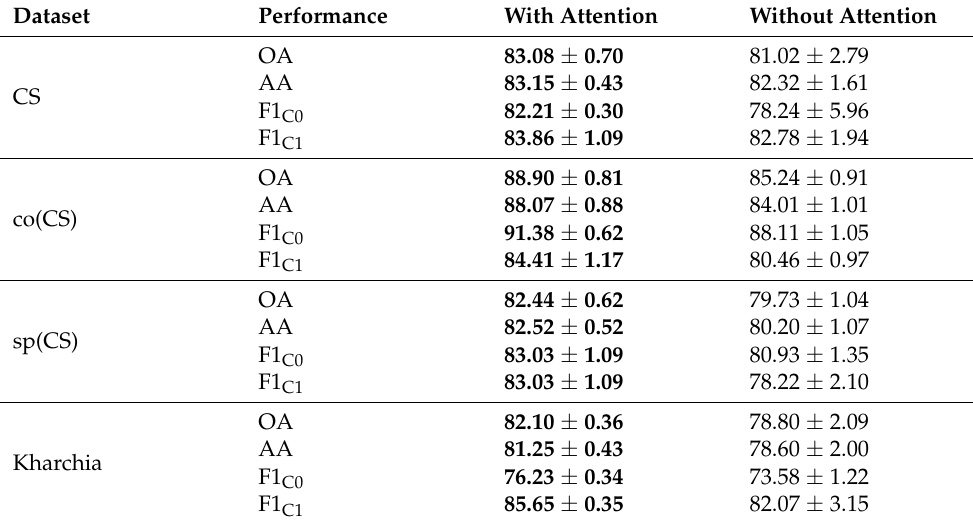
Table 1. Performance comparison between with and without channel attention module. The numbers in bold show the best